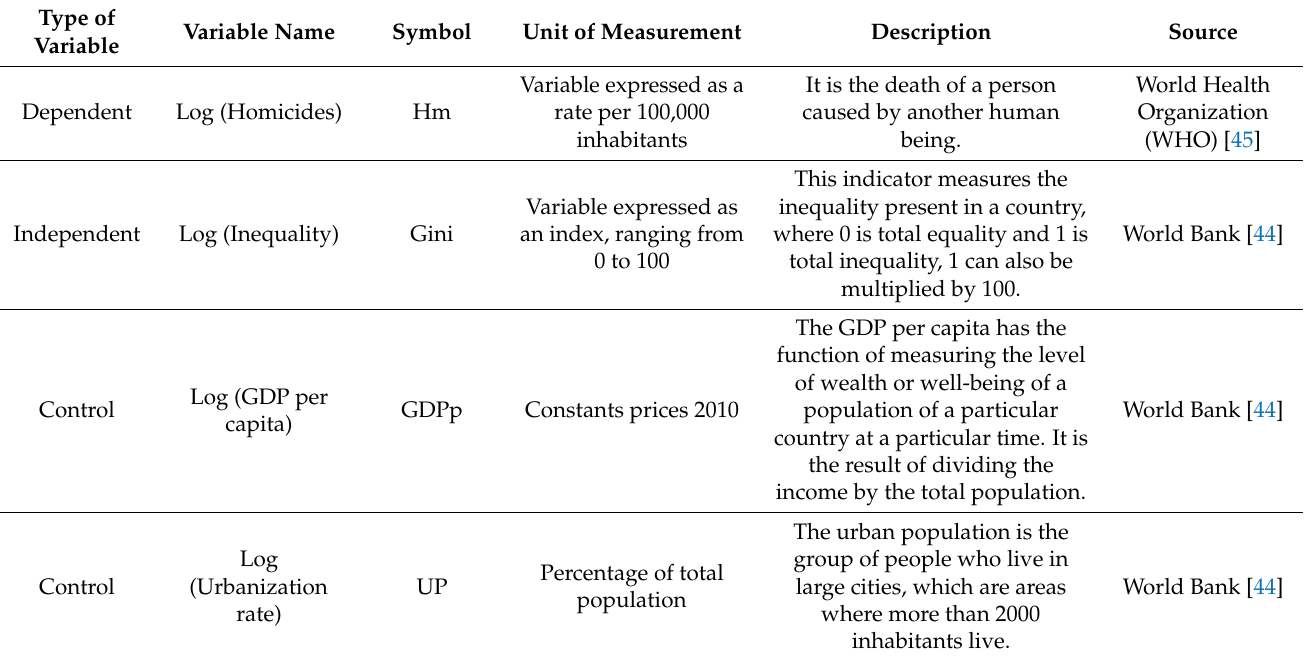
Table 1. Description of